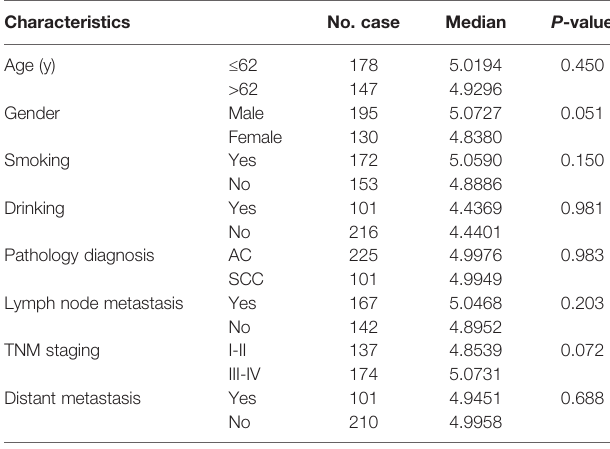
TABLE 1 | Characteristics of NSCLC patients for differentially expressed serum exosomal miR-5684. Characteristics